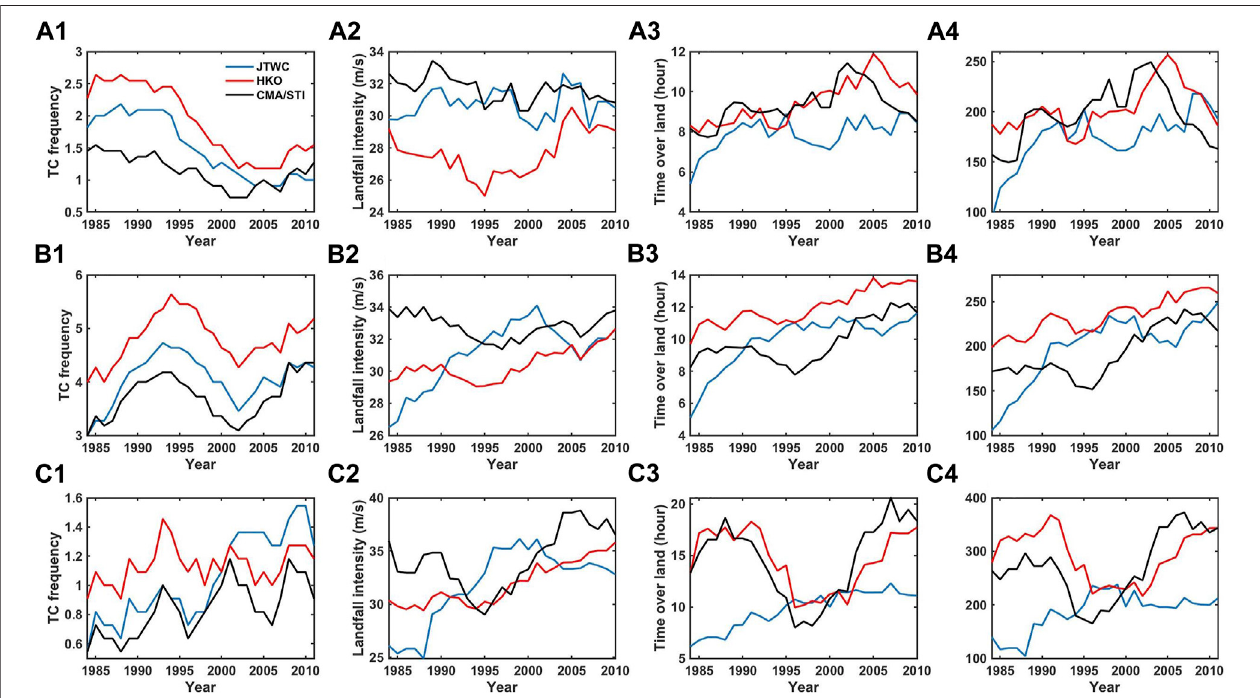
FIGURE 5 | TC inland impacts in different Asian regions. (A1 – A4) show TCs making landfall in the Southeast Asia region (10 – 20 ° N), while (B1 – B4) TCs making landfallintheHanoiandSouthChinaregion(20 – 25 ° N)and (C1 – C4) intheEastChinaregionandabove( > 25 ° N).Panelsinthe fi rstcolumn (A1,B1,C1) aretheTClandfall frequencychange,andthesecond (A2,B2,C2) ,third (A3,B3,C3) ,andfourth (A4,B4,C4) columnsarefortheTClandfallintensity,sustainingtime,andtravelingdistance over the land, respectively. The plots are in 11-year moving average to show clearer changes of the parameters.